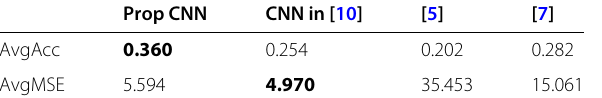
Table 4 Average performance of the proposed CNN estimator in the aligned case for QF 2 = 80, and comparison with the